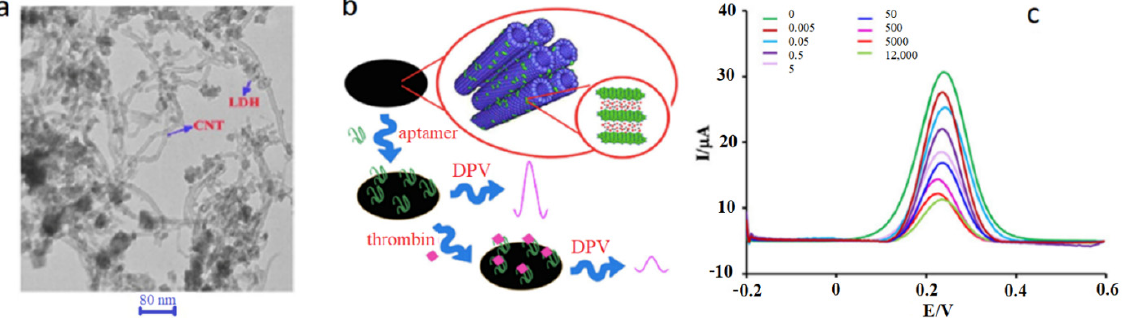
Figure 8. CNT composite-based thrombin aptasensor. ( a ) TEM images of CNT/ZnCr-LDH nanohy- brid, ( b ) sensing mechanism of the aptasensor, and ( c ) DPV signals of aptasensor for different thrombin concentrations. Adapted from [112].